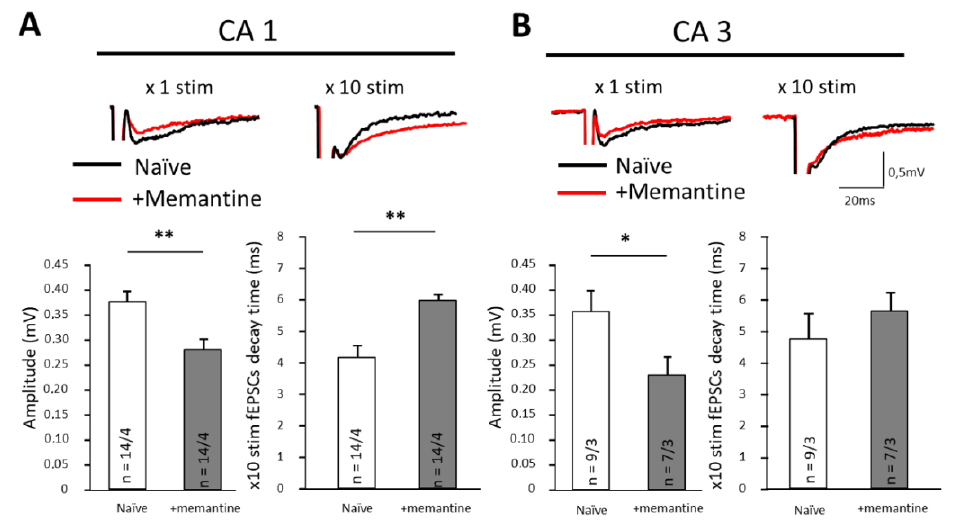
Figure 5. Chronic memantine pre-treatment affects synaptic transmission in hippocampus. ( A ) Recordings from the CA1 area. ( B ) Recordings from the CA3 area. Upper panels—representative traces of fEPSPs after one ( × 1) stimulus or ten ( × 10) stimuli in slices from control mice (black traces) and slices from mice after chronic memantine consumption (red traces). Lower panels—average amplitudes of fEPSPs after × 1 stimulus (left) and average decay times of fEPSPs after × 10 stimuli (right). fEPSPs evoked by a single synaptic stimulus were significantly reduced in both areas of the hippocampus (* p < 0.05; ** p < 0.01). Note that at the time of recording memantine was not present in the bath and would have been largely washed out from the tissue in the course of slice preparation and preincubation. Table 1. Amplitudes and kinetics of fEPSPs in the CA1 area of hippocampus. Are shown the decay time after one (×1 stim.) or ten (×10 stim.) stimuli. Asterisks indicate statistically significant differences (** p < 0.01; n are numbers of tested areas and animals (areas/animals)). CA1 Decay Time ( × 1